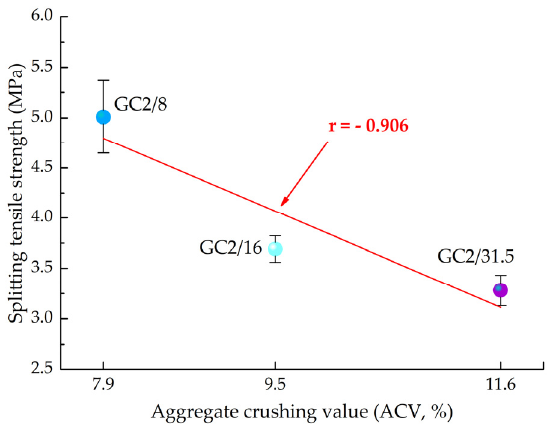
Figure 3. Correlation between aggregate crushing value and splitting tensile strength of concrete.